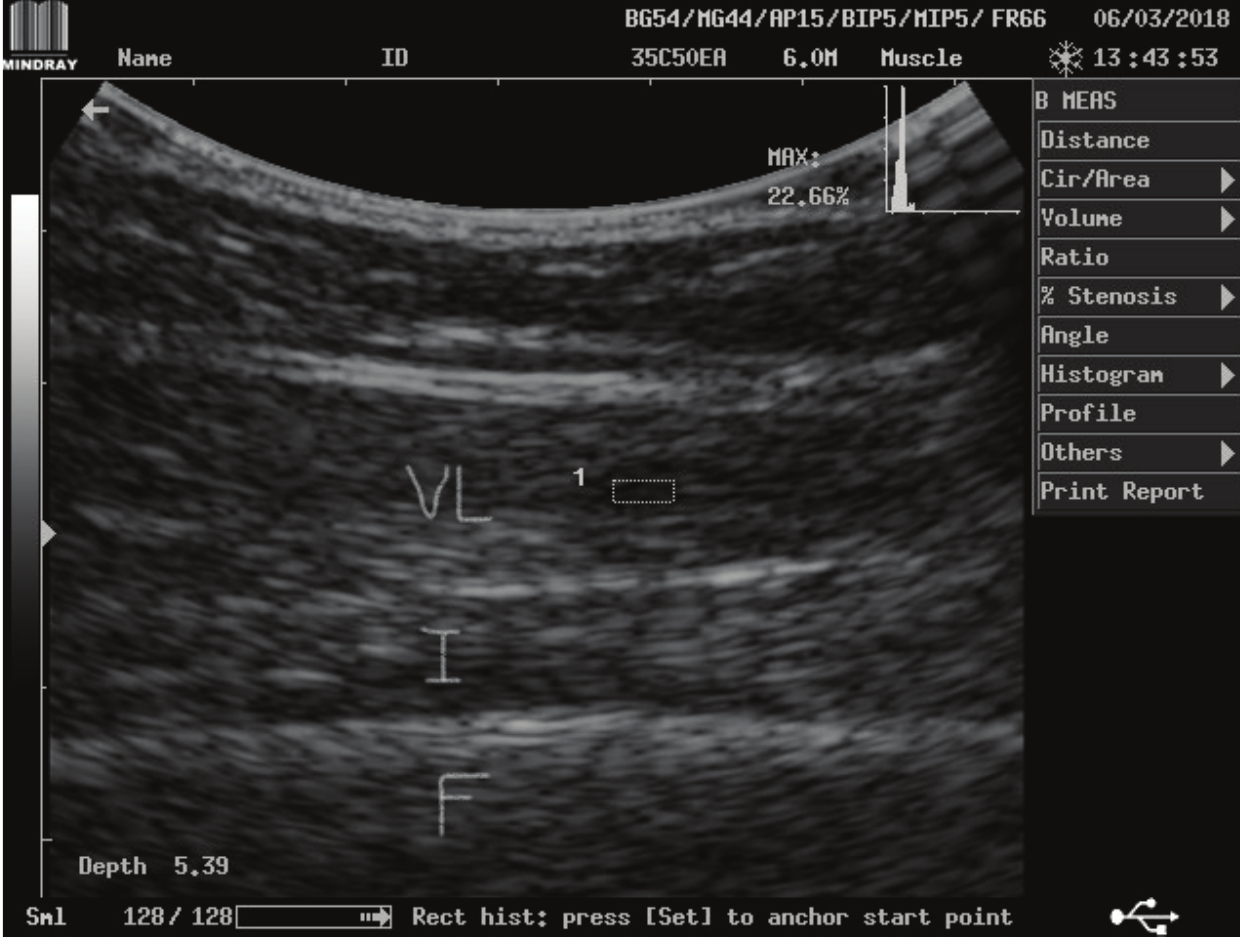
FIGURE 2: Example of measurement of echo intensity of the vastus lateralis muscle of a healthy individual using on-screen callipers of the ultrasound diagnostic imaging